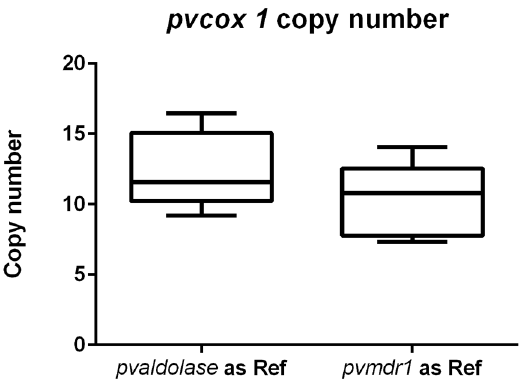
Fig 3. Estimated Plasmodium vivax cox1 copy number based on comparison with two single copy genes, pv aldolase1 and pvmdr1